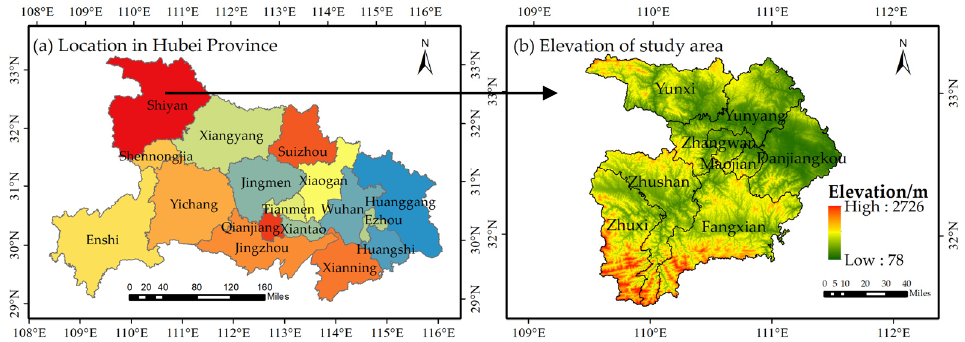
Figure 1. Location and elevation of Shiyan in relation to ( a ) Hubei Province; and ( b ) with eleva-